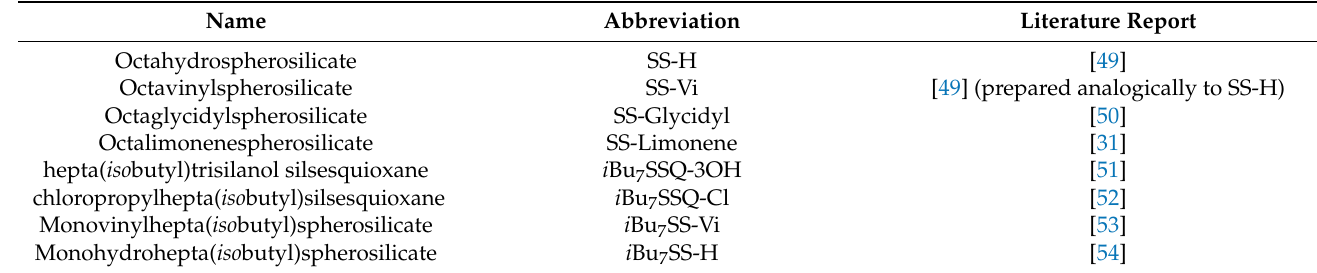
Table 1. Silsesquioxane and spherosilicate derivatives used in this